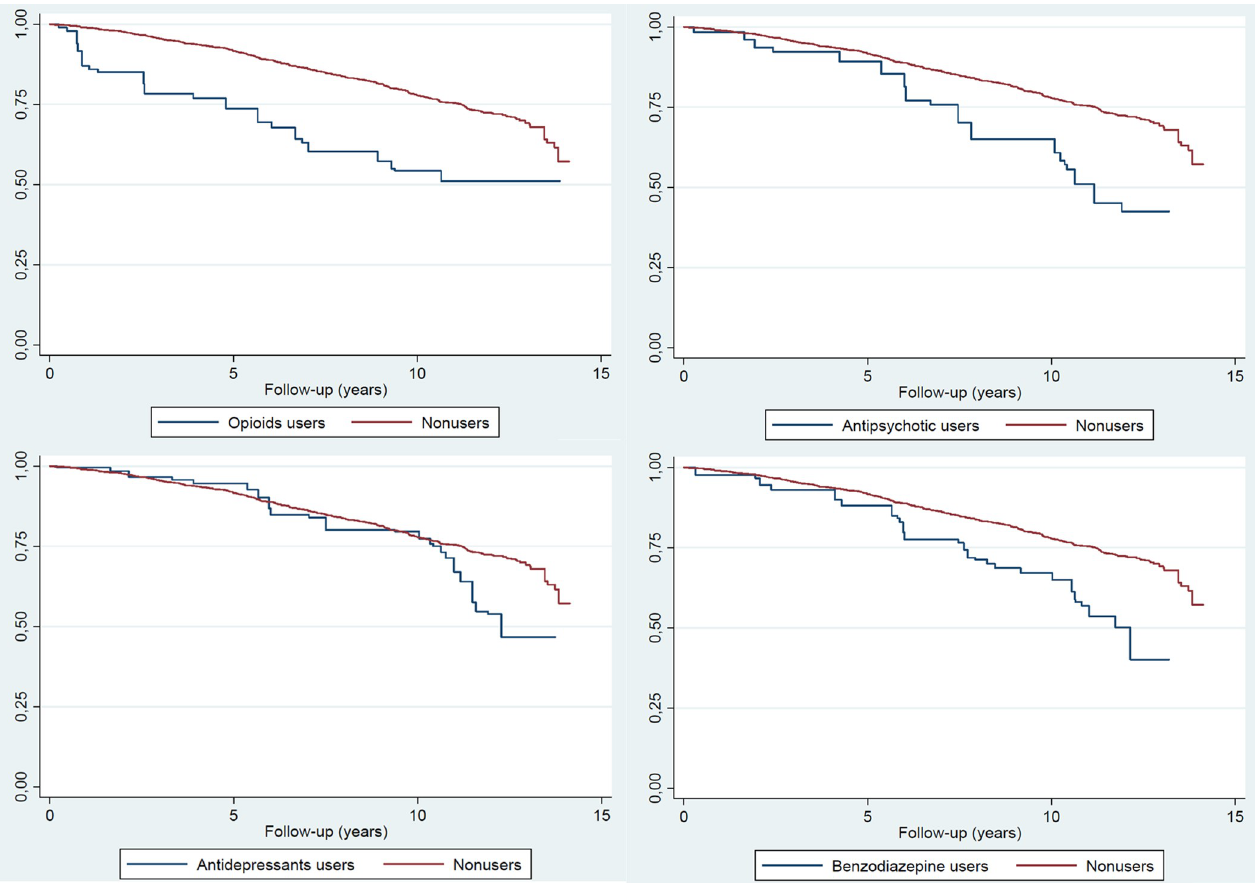
Fig 1. Kaplan-Meier survival estimates for the use of opioids, antipsychotics, antidepressants and benzodiazepines in comparison with nonusers (nonusers: No use of any opioids, antipsychotics, antidepressants and benzodiazepines). GNHIES98 mortality follow-up study.